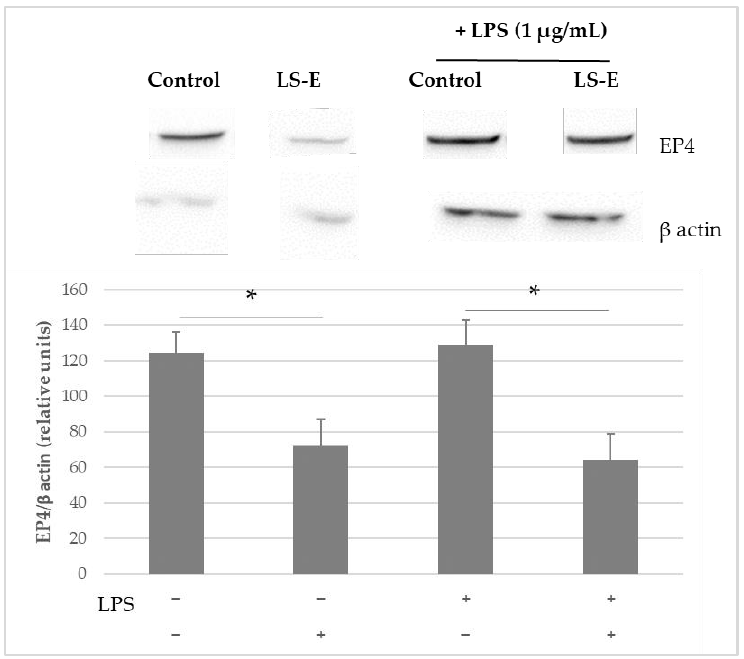
Figure 3. Western blot of EP4 in THP-1 incubated with LPS (1 µg/mL) and with or without LS-E (50 µg/mL) for 1 h; n = 4, *: p ≤ 0.05. Results were expressed as EP4/β actin ratio and control was normalized to 100%, mean values and standard error are given, n = 5. 2.3. LS-E Modulates Gene Expression in IL1 β -Activated Normal Human Articular Chondrocytes The presence of IL1 β strongly induced the expression of IL1 β and matrix metallo- proteinase 1 (MMP1) expression in normal human articular chondrocytes from the knee (NHAC-kn) grown in monolayers, by 73- and 182-fold, respectively (Figure 4). The presence of LS-E (50 µ g/mL) significantly decreased the expression of IL1 β ( × 0.3) and that of the pro- teases MMP1 and ADAMTS4 (a disintegrin and metalloproteinase with thrombospondin motifs 4) ( × 0.5 and × 0.23, respectively), but not MMP2 (Figure 5).